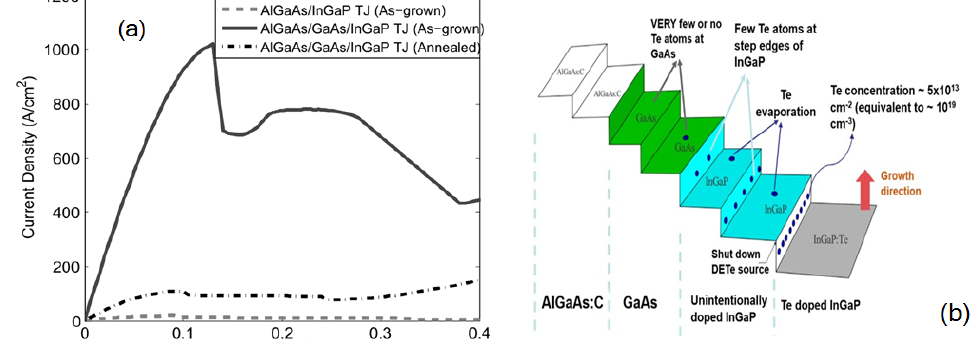
Figure 3. ( a ) Junction grown with a 30-Å quantum well at high growth rate. The annealing occurs for 15 min at 625 ◦ C [17] and ( b ) Te segregation at surface and its effect on grown structure [19].